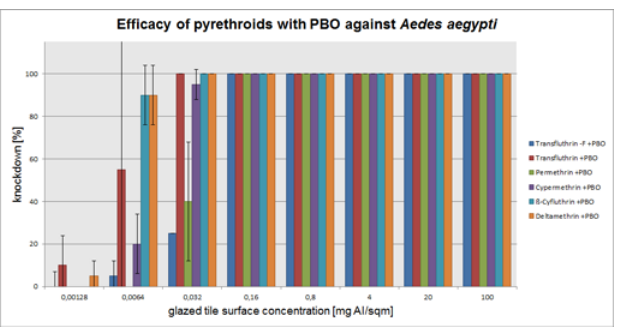
Fig 6. Arithmetic means and standard deviations of the 1 h results of a glazed tile contact bioassay using technical grade pyrethroids with PBO (1600ppm) against insecticide susceptible Aedes aegypti .